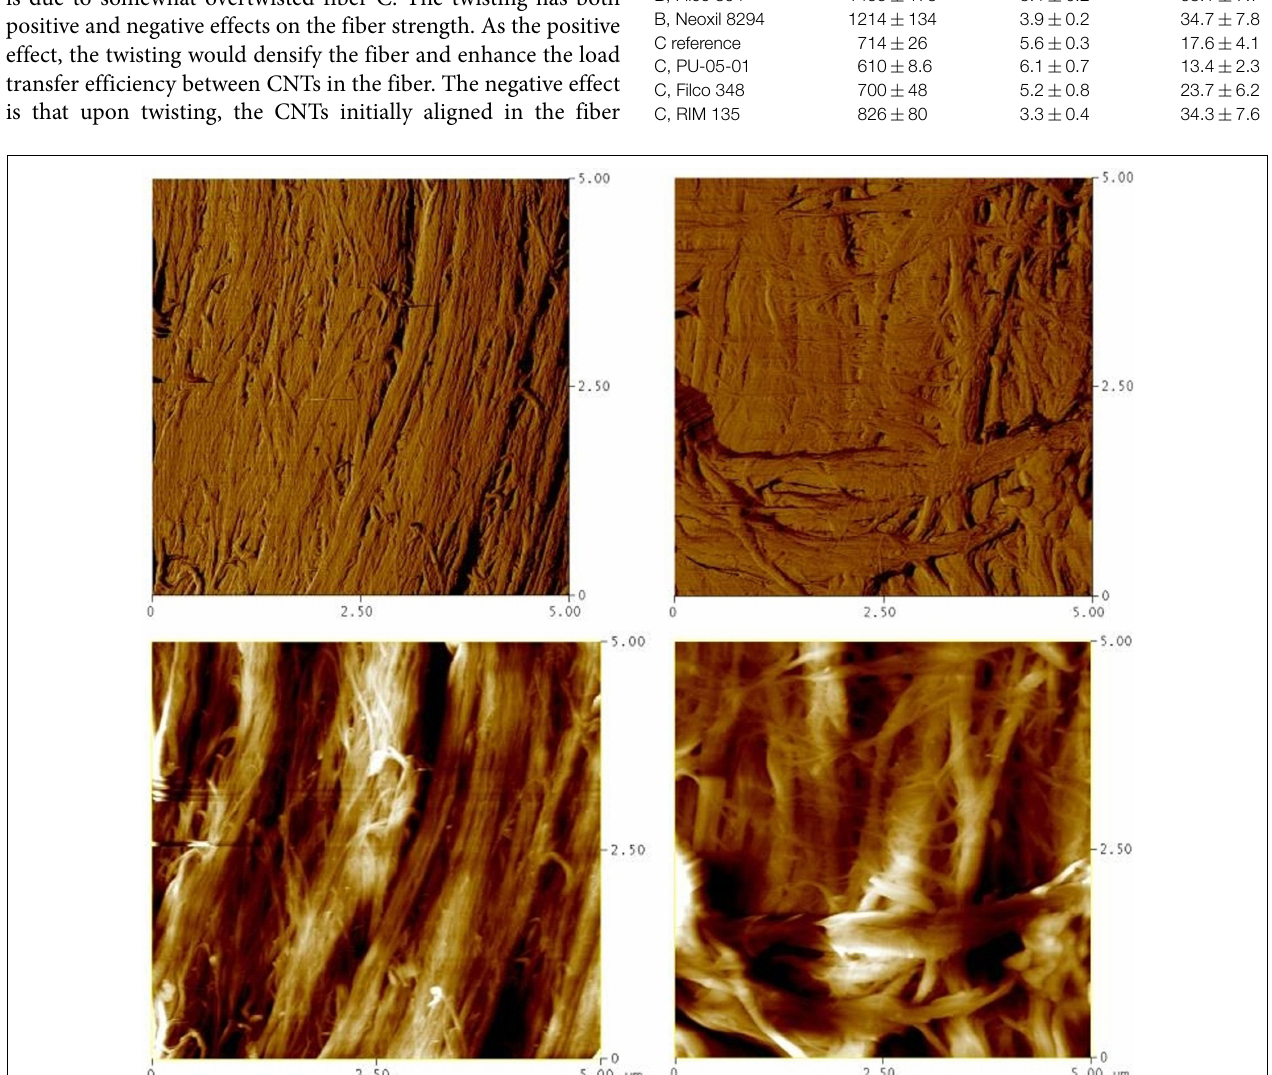
FIGURE 2 | Selected AFM phase and height images (top/bottom), respectively, of reference fibers (left) and Filco 394 treated ones (right) .